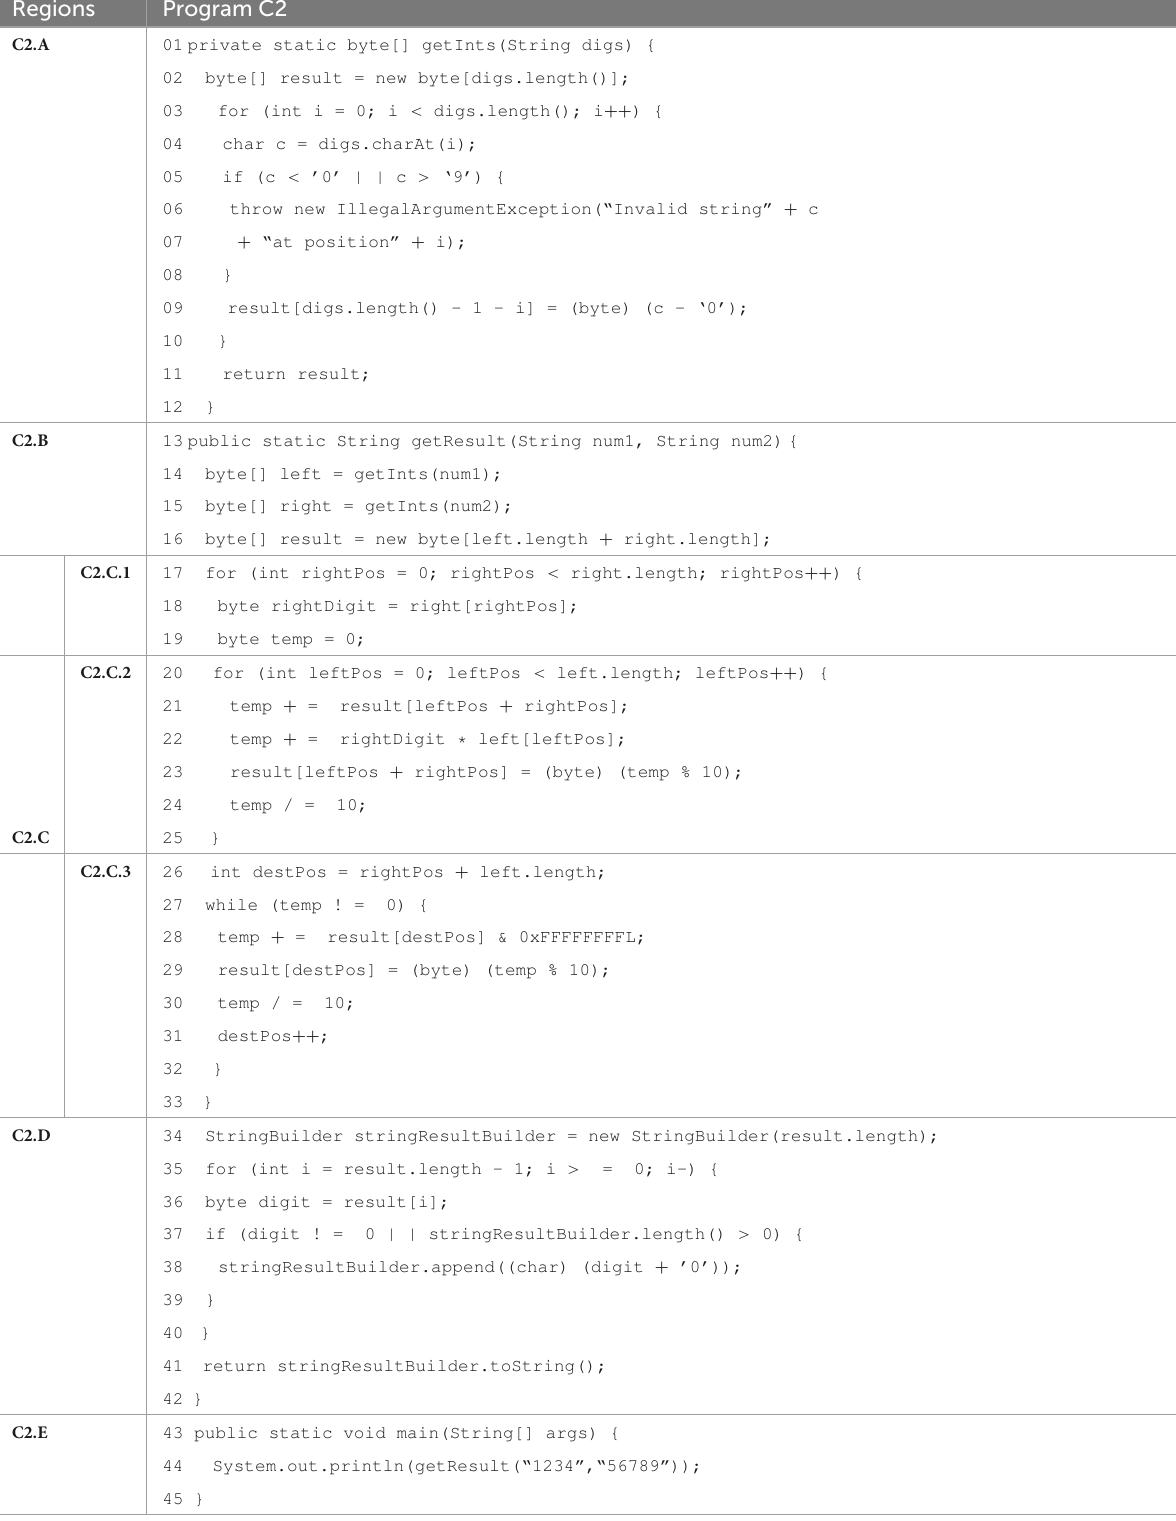
TABLE 2 Region partitions example for C2